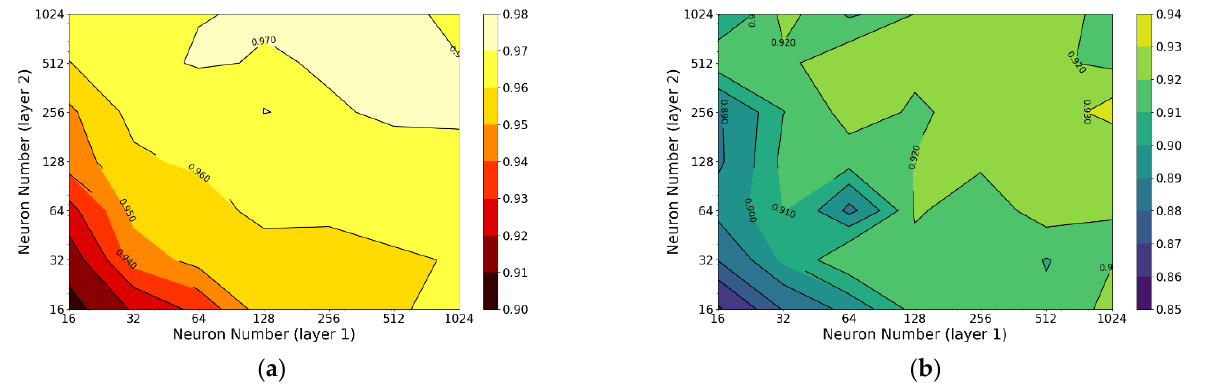
Figure 12. R-square of ANN with different number of neurons in each layer: ( a ) training set and ( b ) test set.